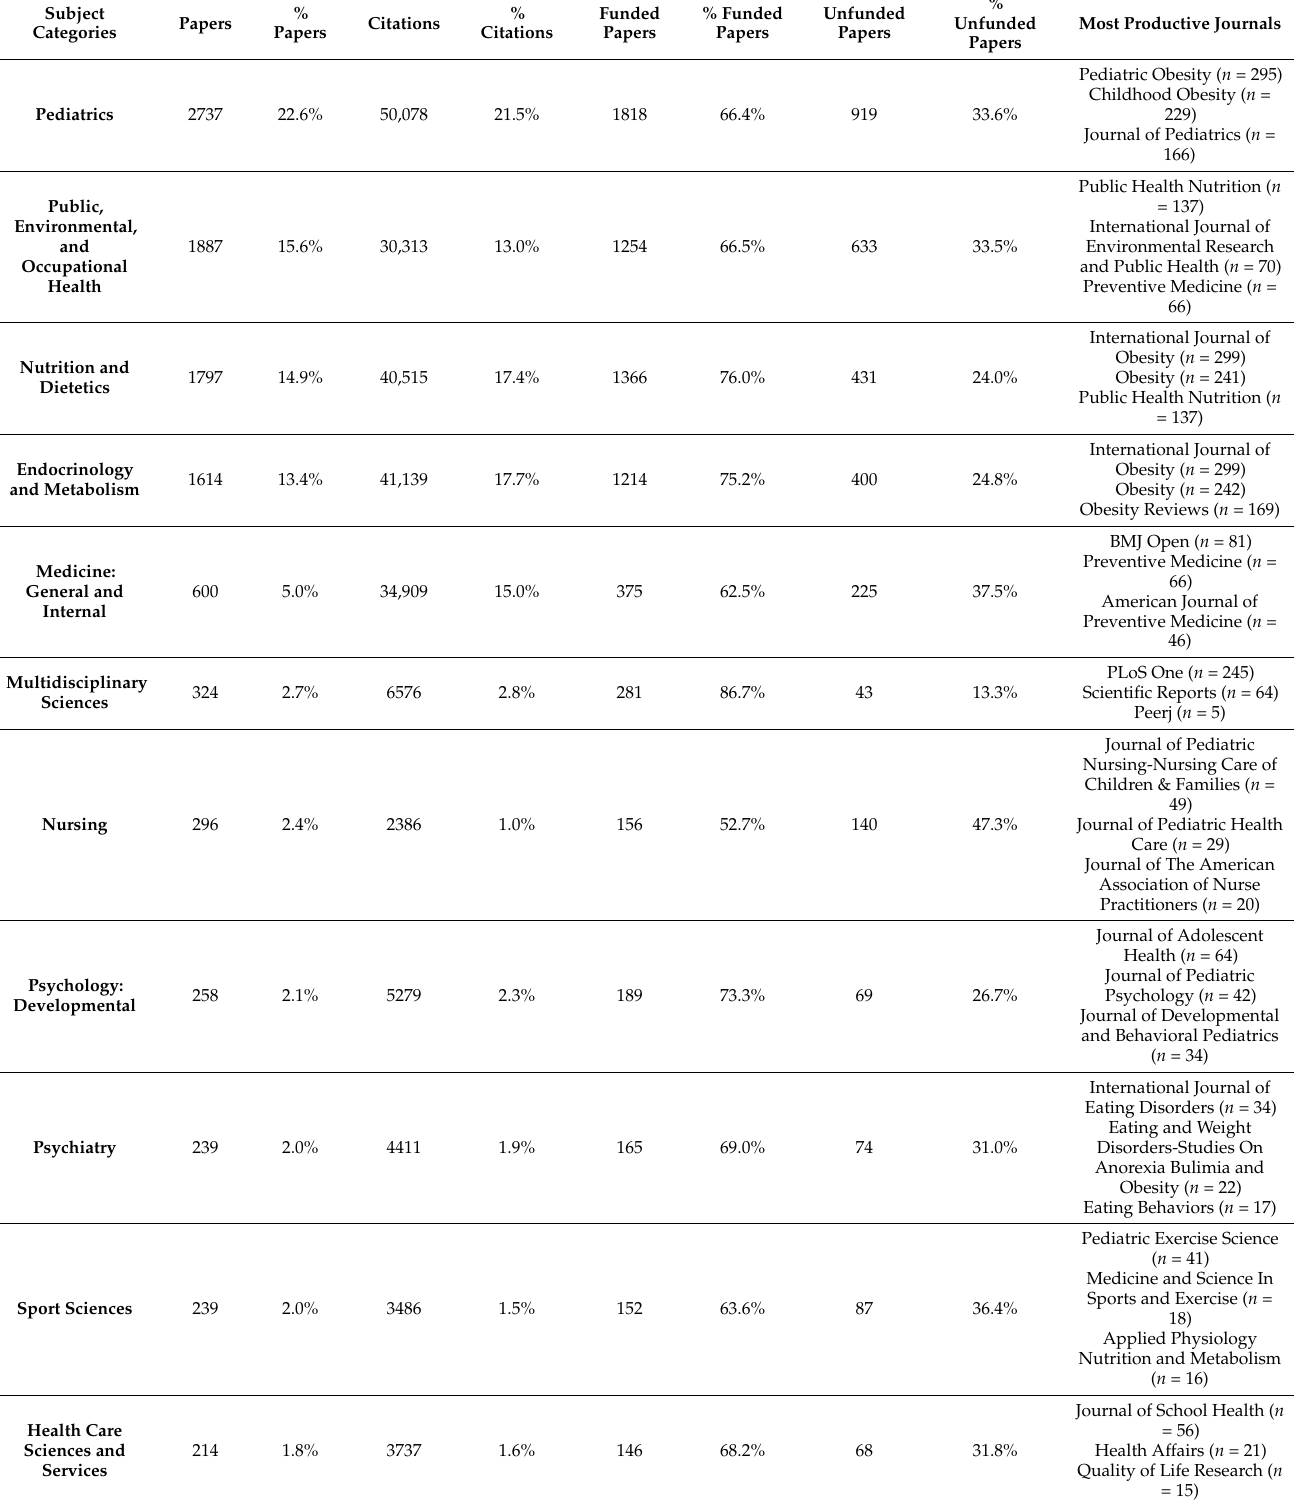
Table 3. Most productive subject categories of journals, citations, citations per paper, and most productive